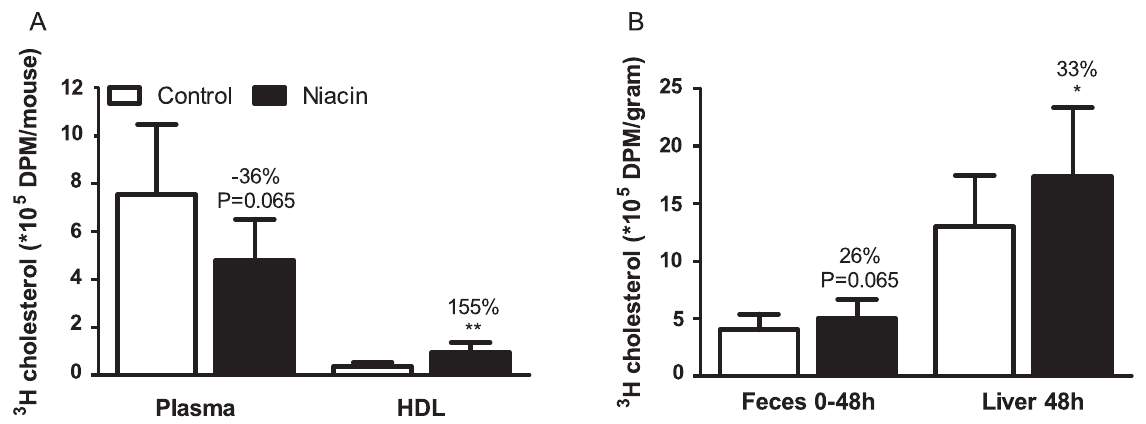
Figure 8. Effect of niacin on reverse cholesterol transport. [ 3 H]-cholesterol-labeled macrophages were injected in control and niacin-treated mice and 3 H activity was determined in plasma and HDL (A) and the liver 48 h after injection, as well as in feces collection between 0–48 h after injection (B). (Values are means 6 SD; n=8 per group; *P , 0.05 and ** P , 0.01 as compared to control).